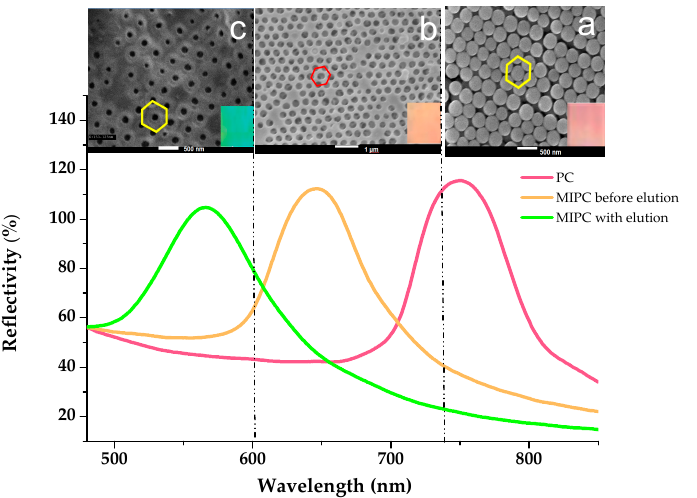
Figure 1. The Bragg diffraction, SEM images and colors (the inset pictures) of PC and MIPC. ( a ) PC, ( b ) MIPC before elution of BP, ( c ) MIPC after elution of BP.